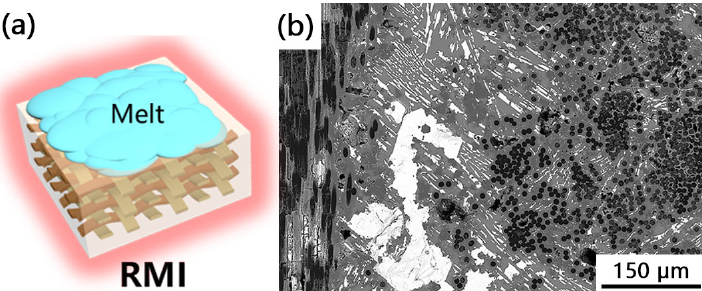
Fig. 19 Schematic diagram of RMI (a); typical microstructure of RMI–C f /ZrC–SiC composites (b). Reproduced with permission from Ref. [209], © The American Ceramic Society 2018.